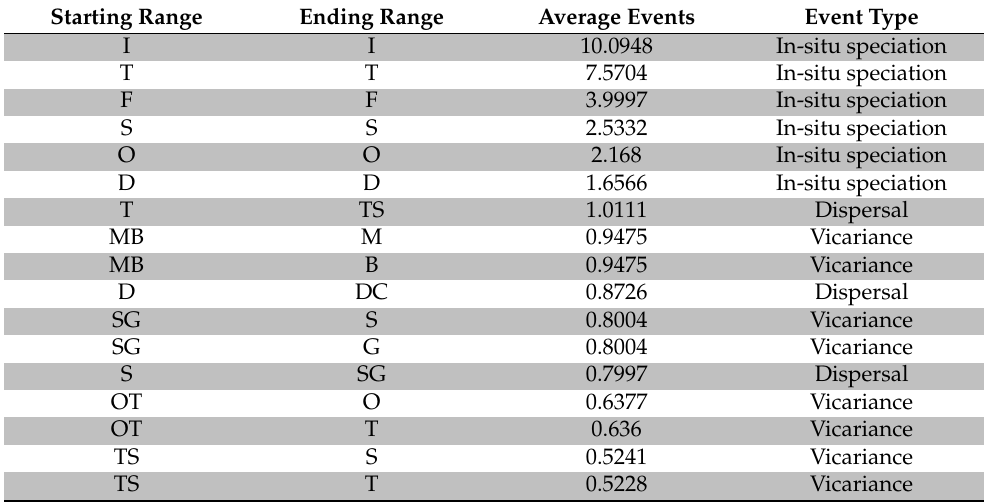
Table 2. List of the most common biogeographic events inferred under DIVA-like, averaged over 100 trees from the posterior